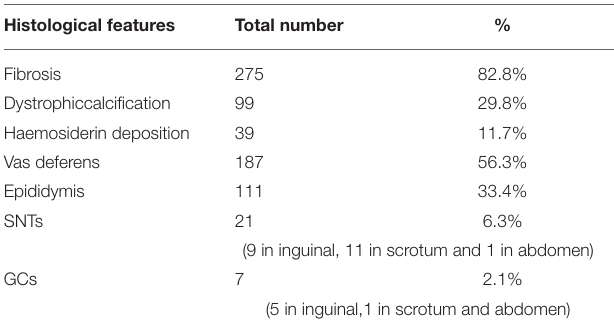
TABLE 1 | Summary of the histological characteristics for vanishing testis specimens ( n =